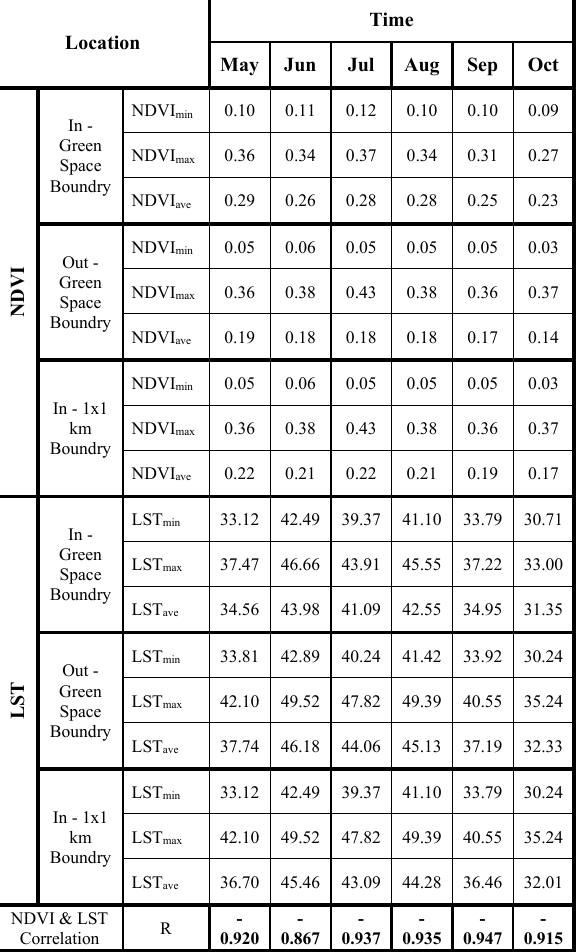
Table 1. NDVI and LST values and NDVI & LST Correlation of Hayat Park and surrounding urban